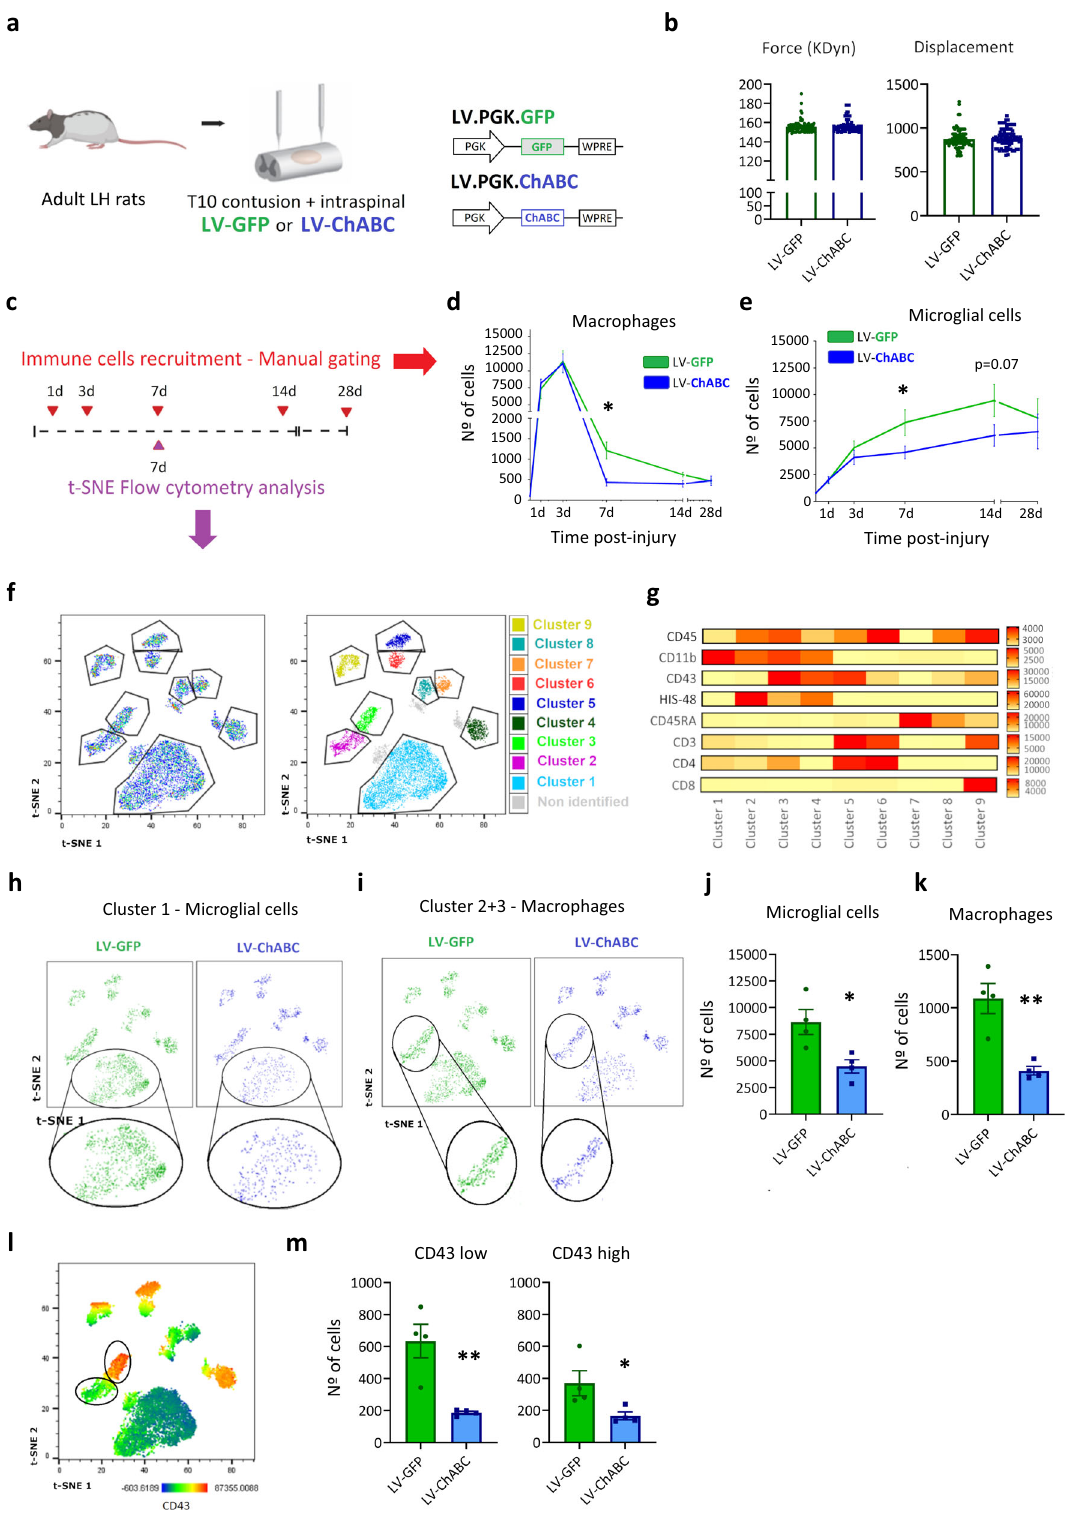
(Fig. 1f, g). In agreement with our observations with manual- gating fl ow cytometry analysis (Fig. 1d), CSPG digestion signi fi cantly reduced the monocyte/macrophage population within the injury epicentre at 7 dpi (Fig. 1i, k). Furthermore, t-SNE analysis identi fi ed two different monocyte/macrophage subsets based on differential expression of CD43, cluster 2 (CD43 low ) and cluster 3 (CD43 high ) (Fig. 1f, g, l). The effect of